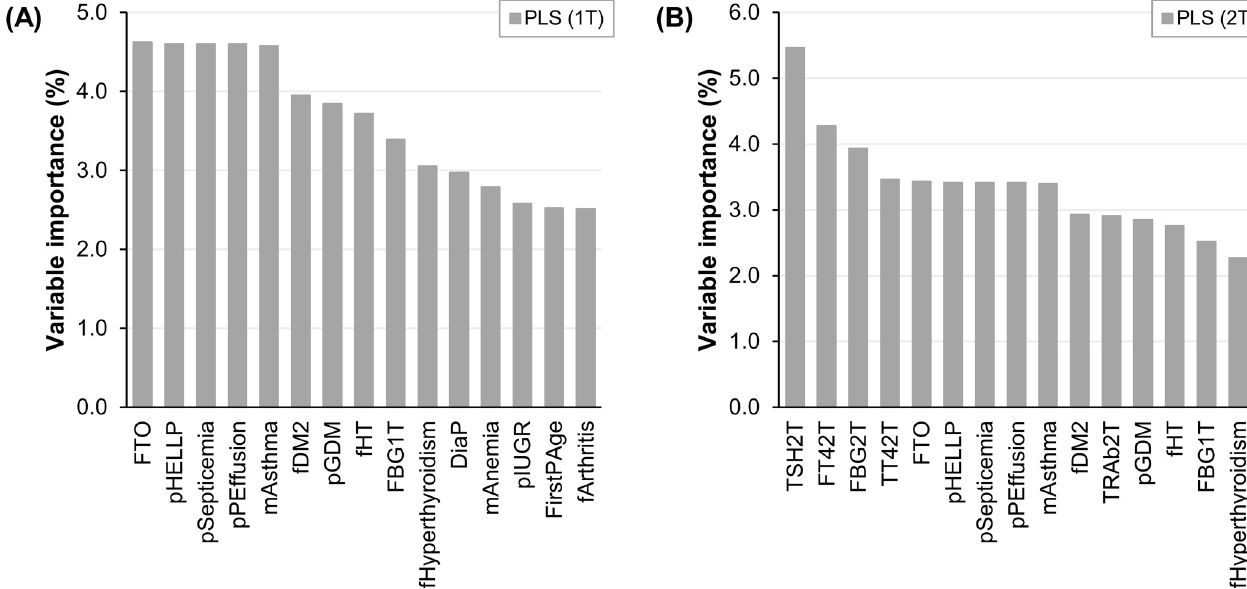
Fig 3. Variable importance of the machine learning models that predict post load glycemia with best performance. (A) Built on first trimester data only. (B) Including second trimester data. 1T : First trimester . 2T : Second trimester . PLS : Partial least squares . FTO : Fat mass and obesity-associated genotype (rs9939609) . pHELLP : Prior hemolysis elevated liver enzymes and low platelets syndrome . pSepticemia : Prior septicemia . pPEffusion : Prior pleural effusion . mAsthma : Personal asthma . fDM2 : Family history of type 2 diabetes . pGDM : Prior gestational diabetes mellitus . fHT : Family history of hypertension . FBG : Fasting blood glucose . fHyperthyroidism : Family history of hyperthyroidism . DiaP : Diastolic pressure . mAnemia : Personal anemia . pIUGR : Prior intrauterine growth restriction . FirstPAge : First period age . fArthritis : Family history of rheumatoid arthritis . TSH : Thyroid stimulating hormone . FT4 : Free thyroxine . TT4 : Total thyroxine . TRAb : TSH receptor antibody